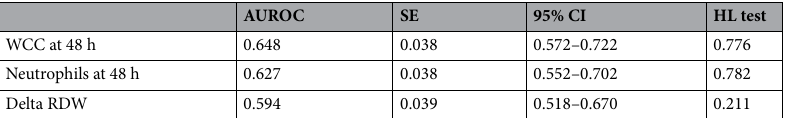
Table 6. Area under the receiver operating characteristic curve (AUROC) for diagnostic differentiation of viral versus bacterial pneumonia. HL test Hosmer ‒ Lemeshow goodness-of-fit